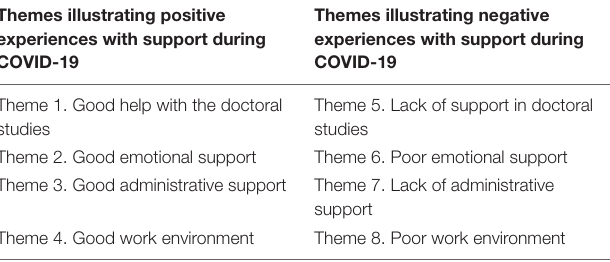
TABLE 6 | Overview of themes from a thematic analysis of the interview data. Themes illustrating positive experiences with support during COVID-19